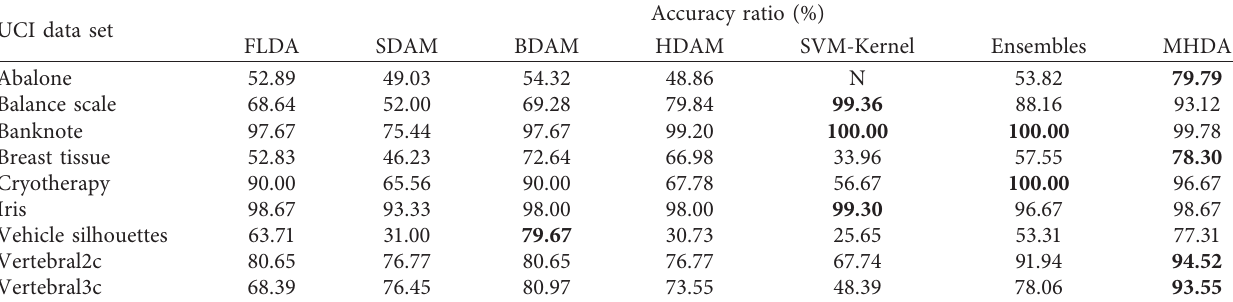
Table 2: Accuracy ratio of different methods.